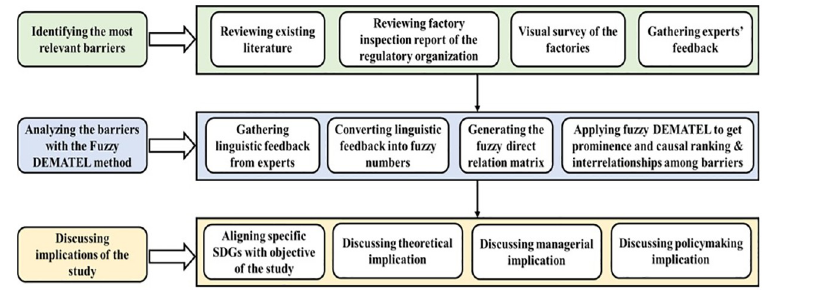
Fig 4. Proposed framework for this